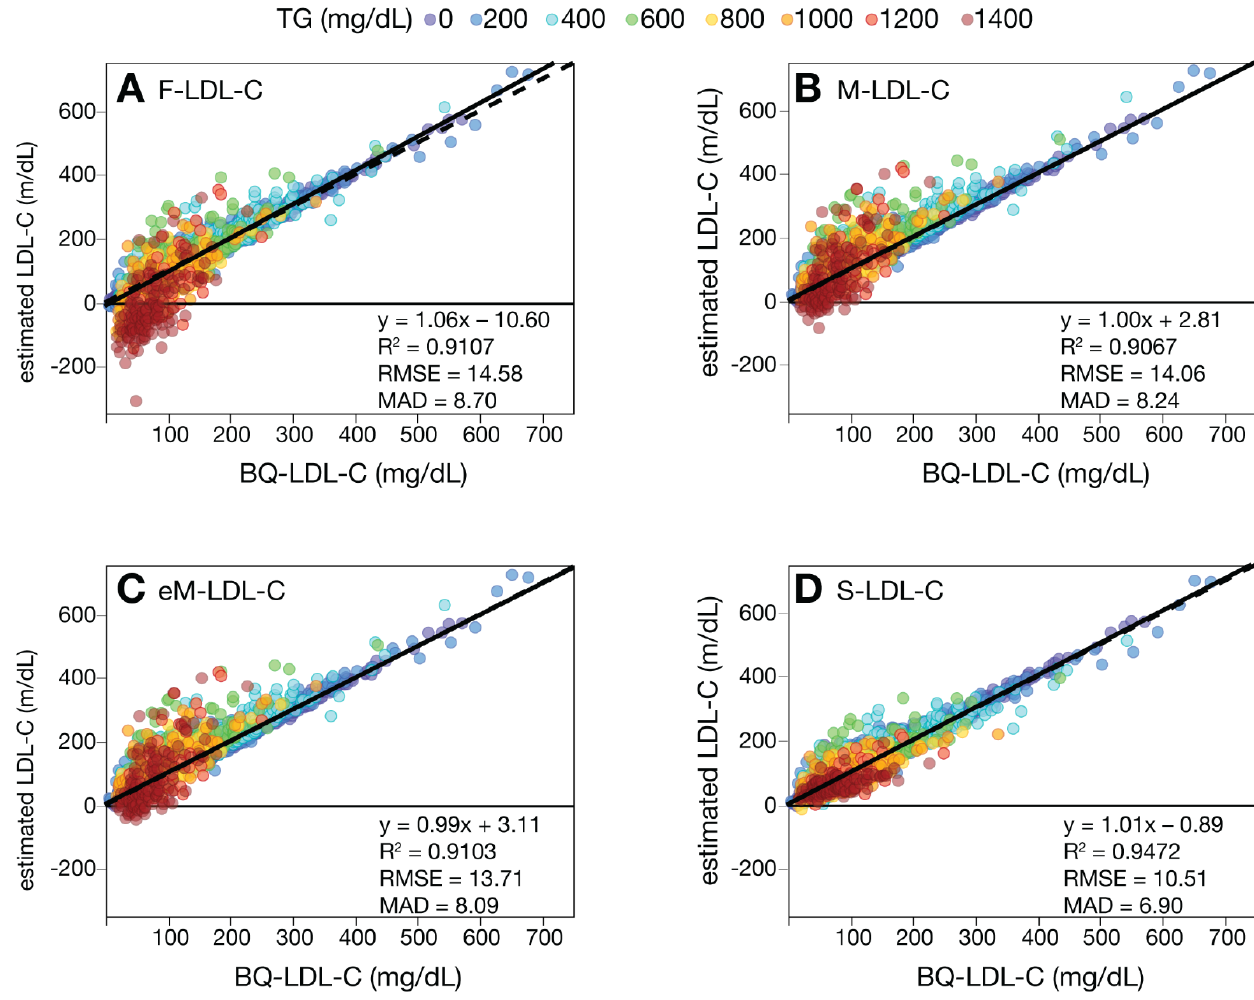
Figure 1. Comparison of estimated LDL-C versus BQ-LDL-C. LDL-C was calculated in patients (N = 39,956) with a wide range of LDL-C values by F-LDL-C, (Panel A ), M-LDL-C (Panel B ), eM-LDL-C (Panel C ) and S-LDL-C (Panel D ) equations and plotted against LDL-C as measured by BQ reference method (BQ-LDL-C). Solid lines are linear fits for the indicated regression equations. Dotted lines are lines of identity. Results are color coded by TG level with the value in the legend (mg/dL) indicating the start of each interval.